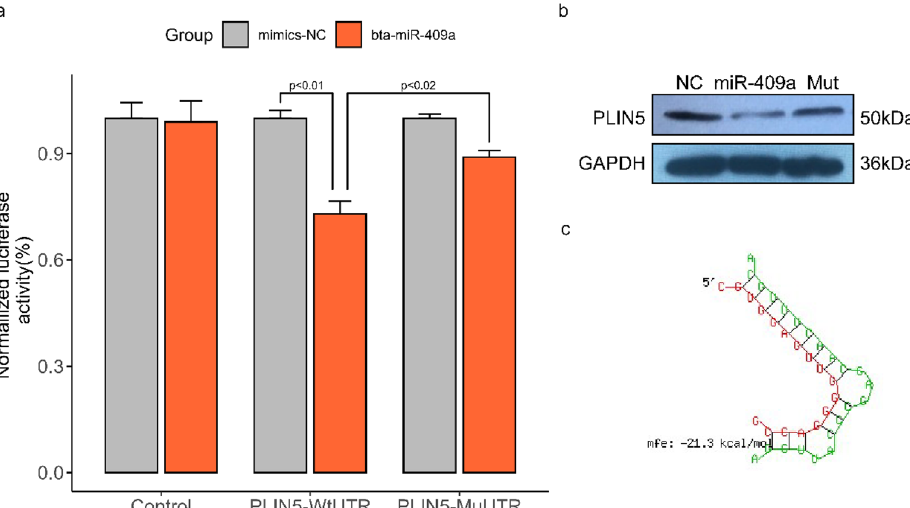
Figure 7. Validation of miRNA endogenous targets via dual-luciferase reporter and Western blot assay. ( a ) Showed the activity of PLIN5 and bta-miR-409a by binding assay. ( b ) Presented the validating of PLIN5 as a target of bta-miR-209a at the protein level using western blot. Three tracks were captured from the original full- length membrane image and were presented in the same order consistent with ( a ). ( c ) is nucleotide sequences of binding sites located in the 3 ′ UTR of PLIN5. The sample derives from the same experiment, and that blots were processed in parallel. The party of the full-length membrane image is presented in Supplementary Fig.